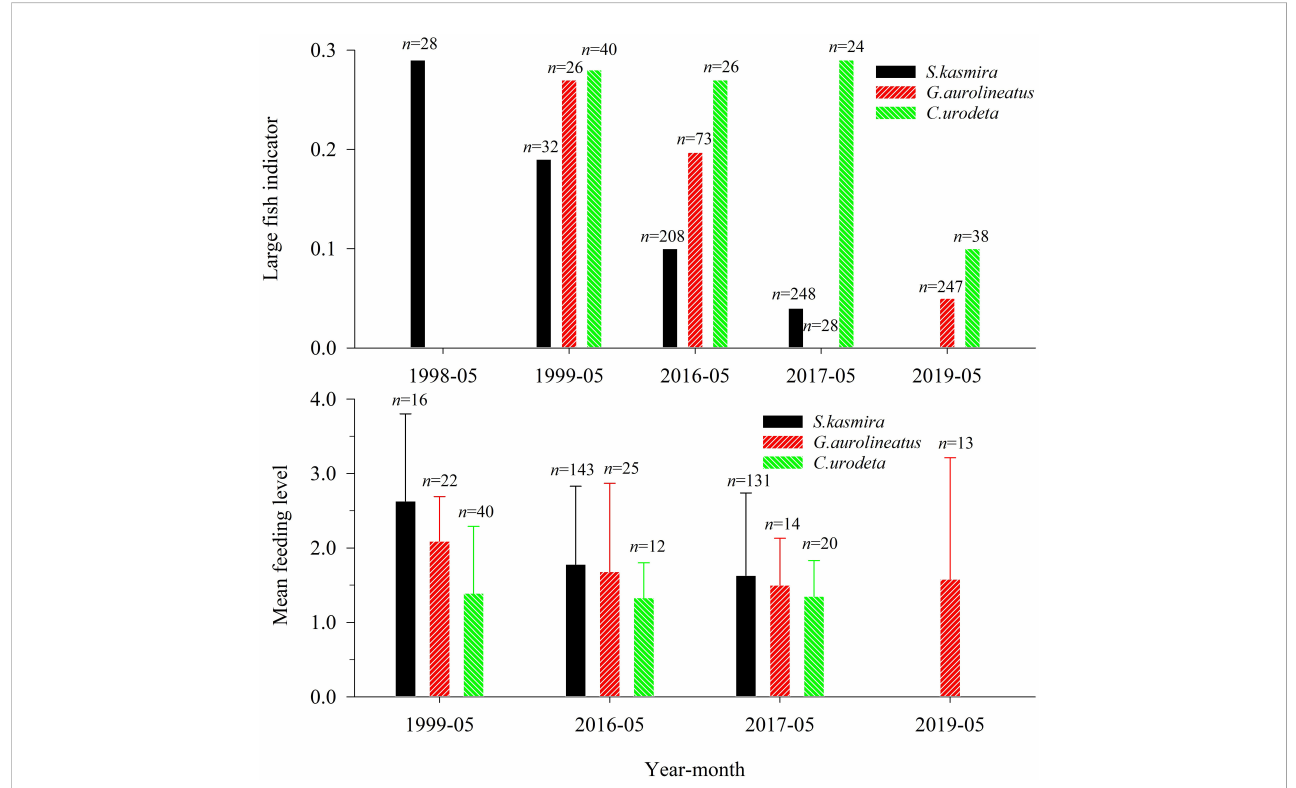
FIGURE 3 Large fi sh indicator and mean feeding level of Lutjanus kasmira , Gnathodentex aureolineatus and Cephalopholis urodeta during 1998 – 2019 in the Yongshu Reef, South China Sea. The error bar represents the corresponding standard deviation. The n above the error bar represents the number of corresponding replicate